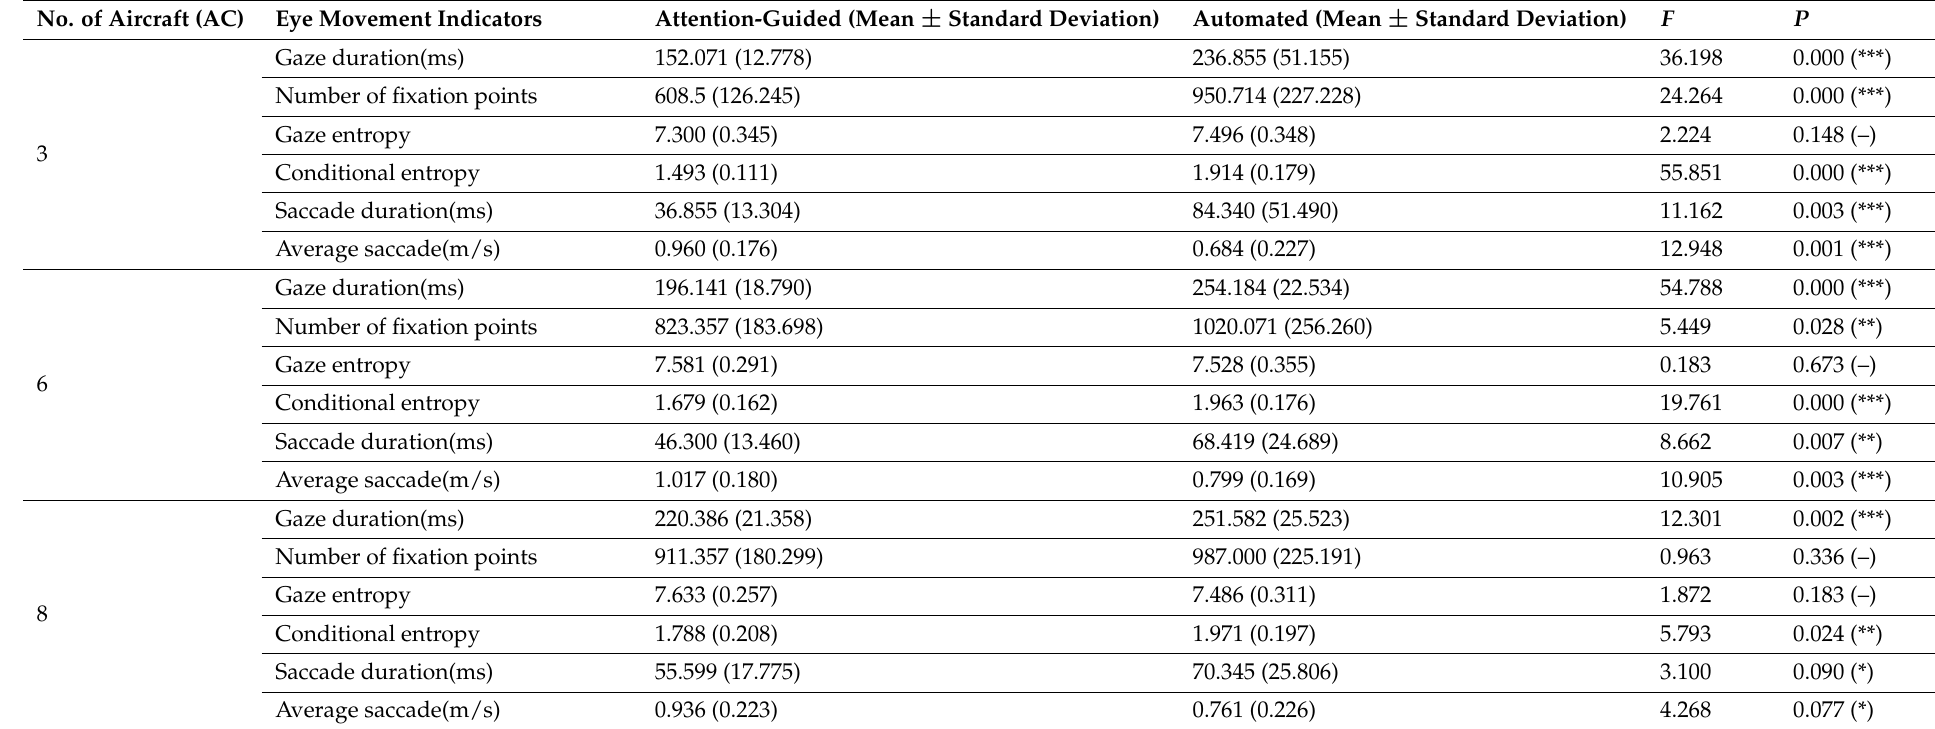
Table 6. Significant analysis of participants’ eye movements under the attention-guided mode and under the automated